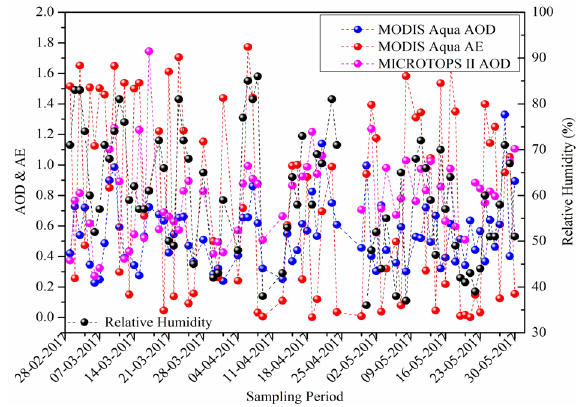
Figure 3: Temporal variation of MICROTOPS II AOD, MODIS Aqua AOD and AE and